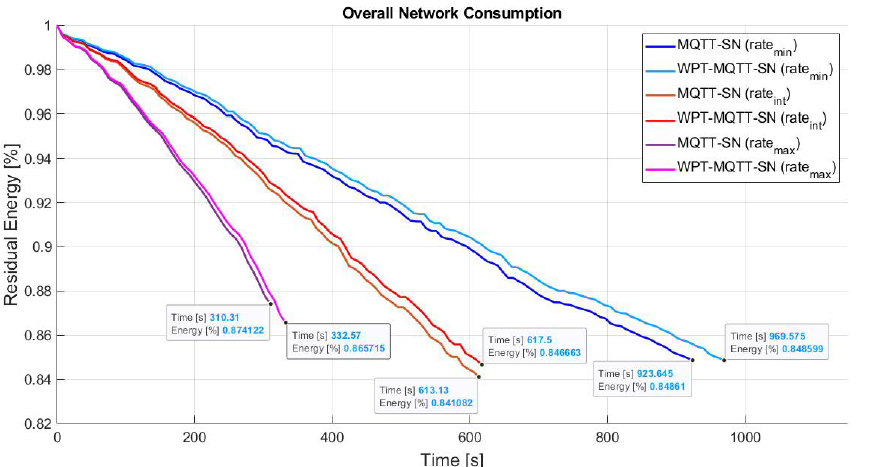
Figure 13. Comparison of MQTT-SN protocols without and with WPT for different Publishing rates in Two-Tier star based topology.